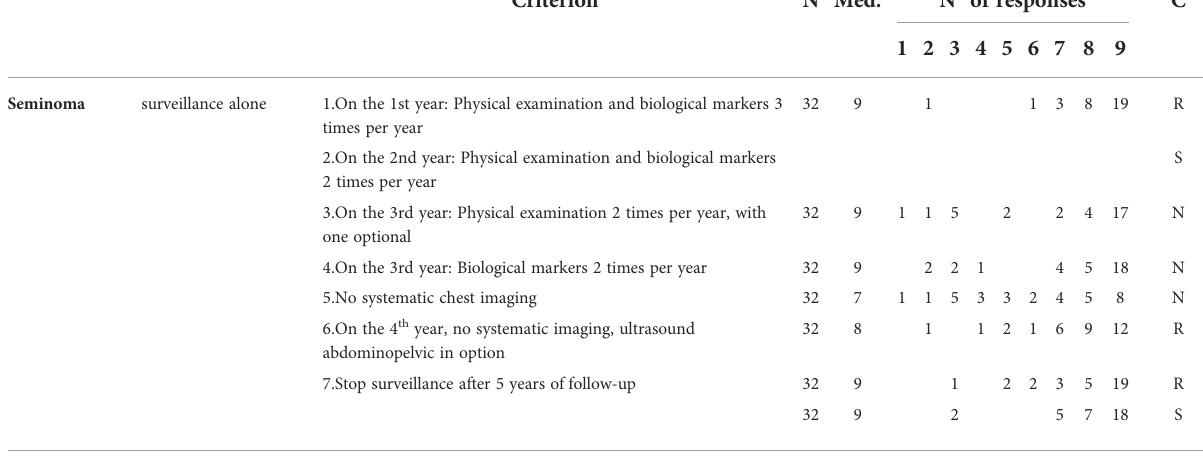
TABLE 5 Results of the rating process following the second round of Delphi consensus